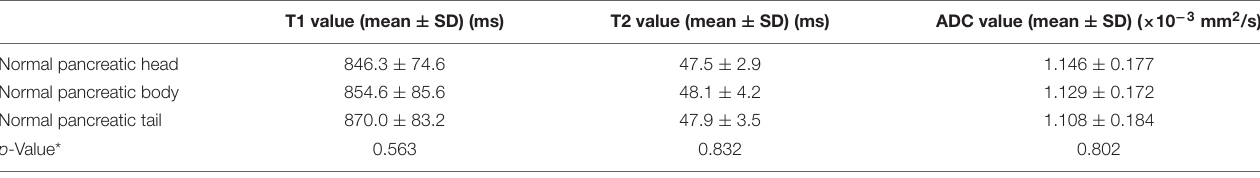
FIGURE 8 | Receiver operating characteristic curves of the diagnostic performance of T1, T2, and ADC values and the different combinations of parameters in the differentiation of PDAC. The AUCs (95% CI) are T1 [0.901 (0.874–0.928)], T2 [0.552 (0.507–0.598)], and ADC values [0.712 (0.672–0.752)]. Combination of two parameters, the AUCs (95% CI) of T1 + ADC [0.934 (0.914–0.953)], T1 + T2 [0.913 (0.887–0.938)], and T2 + ADC [0.725 (0.686–0.763)]. The AUCs (95% CI) for the combination of T1, T2, and ADC are [0.937 (0.918–0.956)]. TABLE 4 | T1, T2, and ADC values of normal pancreatic head, body, and tail.